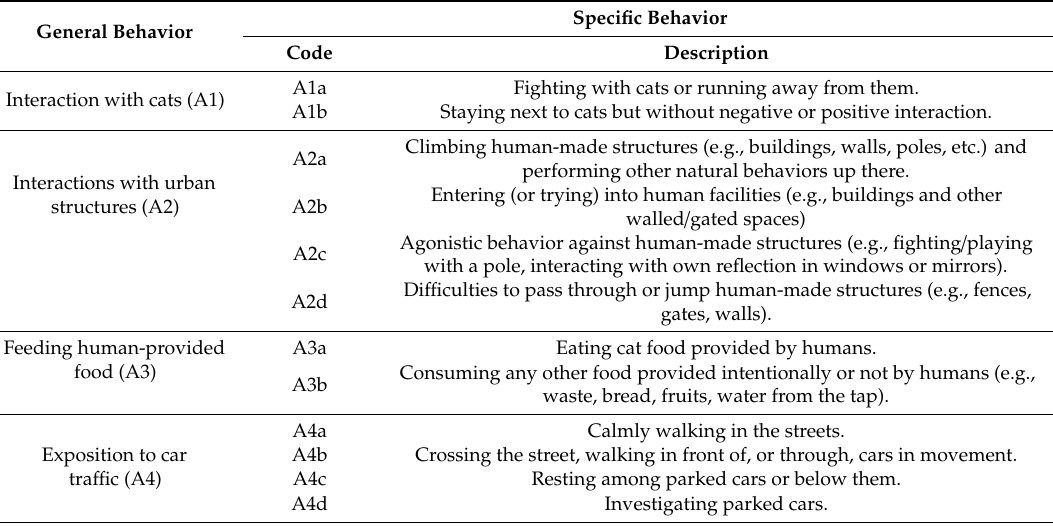
Table 1. Description of behaviors of Red-legged Seriema related to anthropogenic factors that were observed in the Luiz de Queiroz